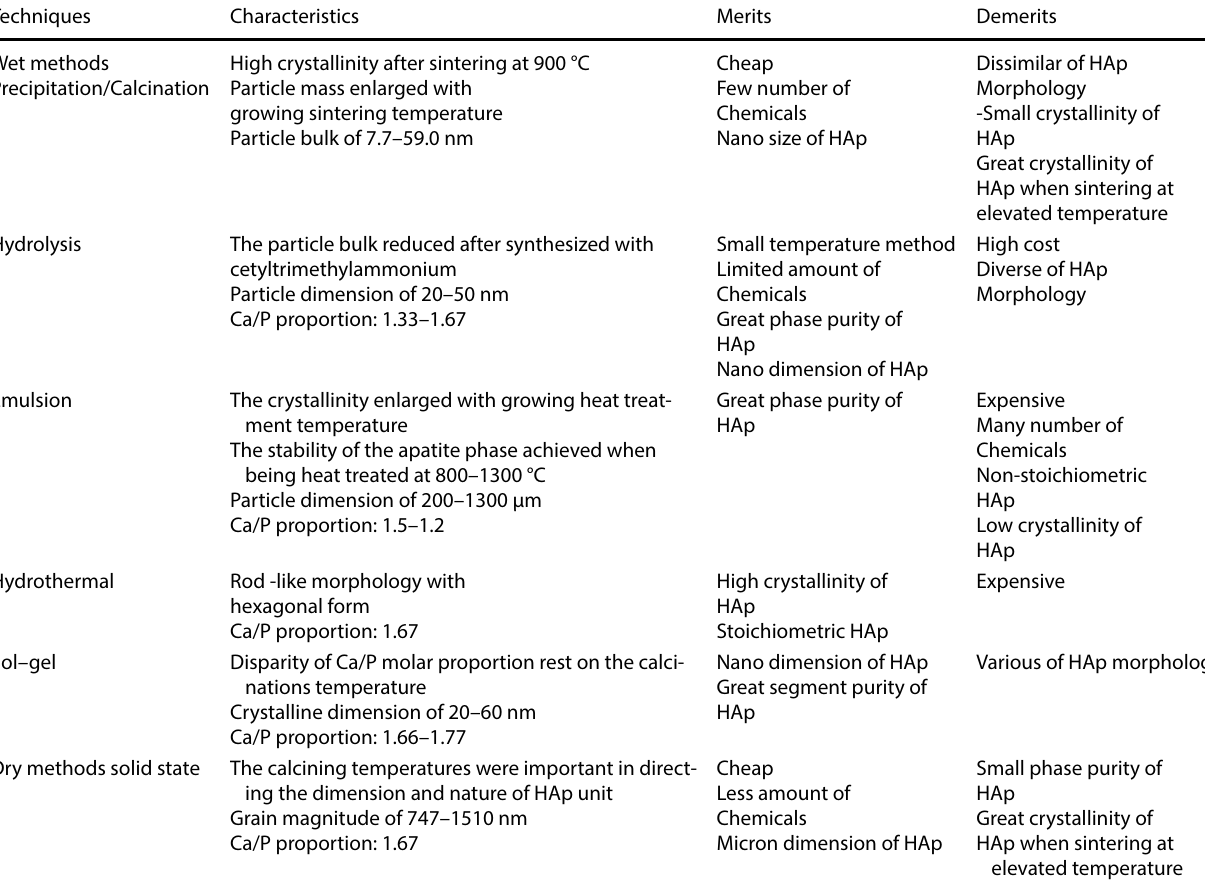
Table 2 Diverse ways to produce HAp powder [15] Techniques